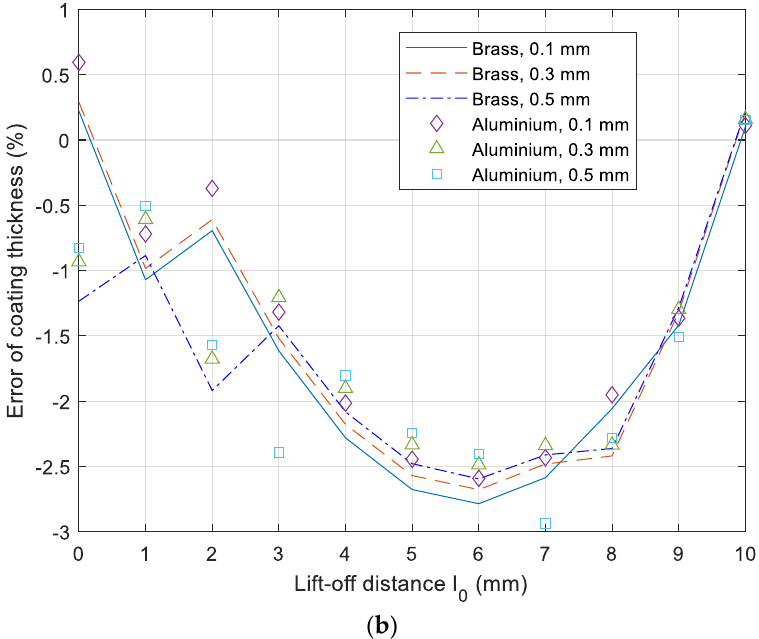
Figure 10. Inverse of coating thickness versus lift-off distance: ( a ) absolute value and ( b ) error.